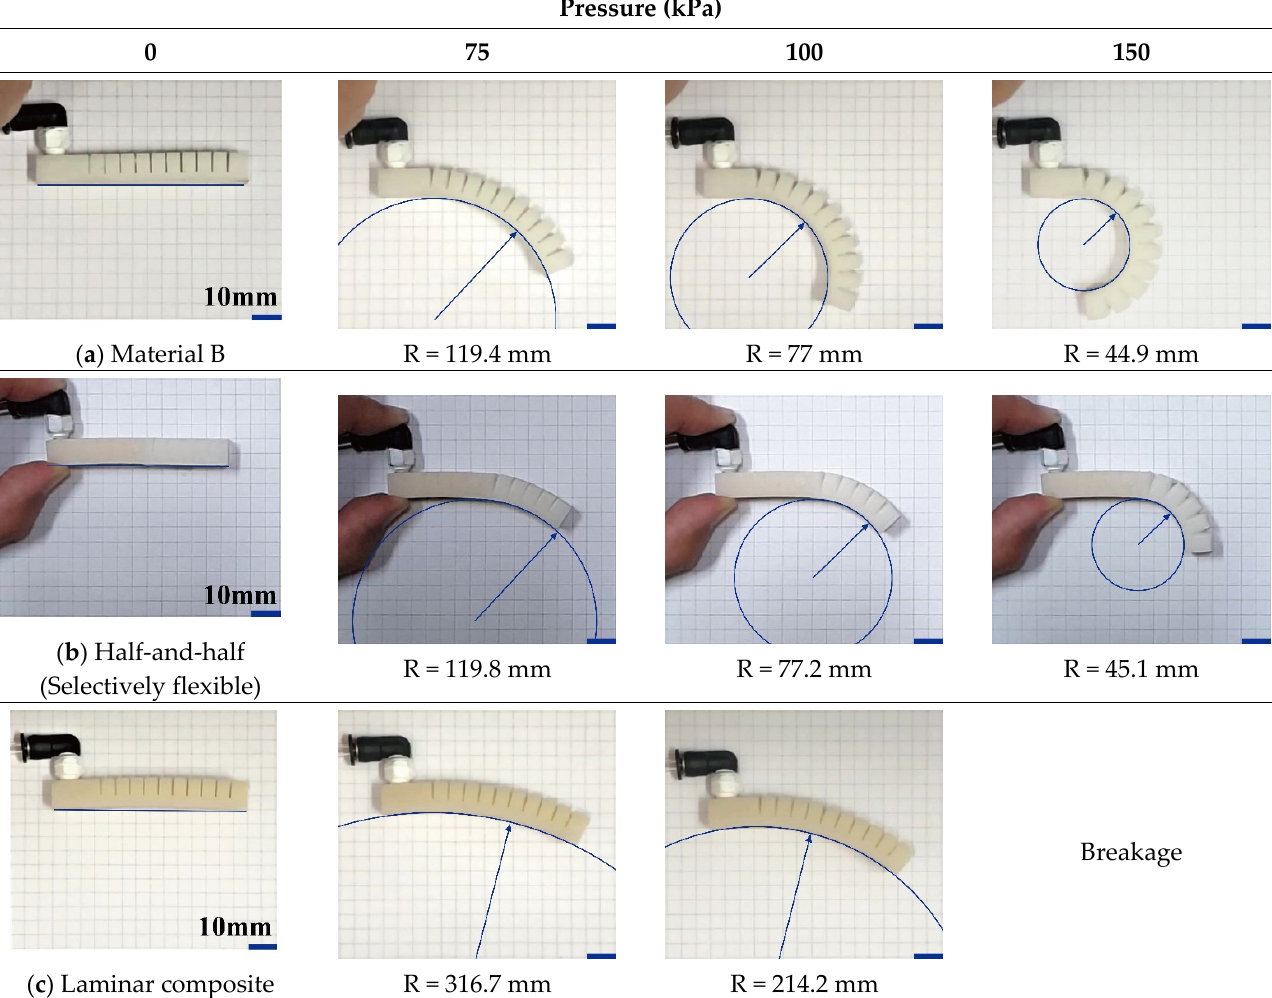
Figure 18. Deformation of soft grippers with different 3D-printed material structures in the pneumatic test .